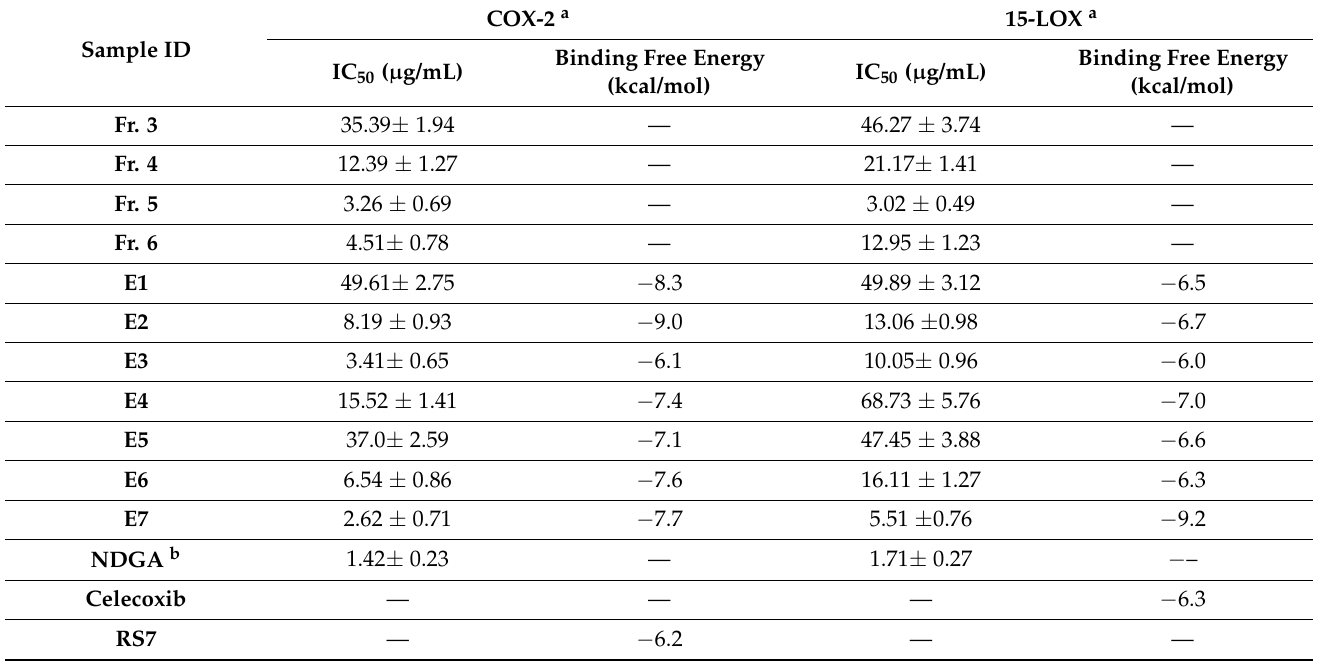
Table 5. IC 50 and binding free energies of cyclooxygenase-2 (COX-2) and 15-lipoxygenase (15-LOX)- inhibitory activities of the selected sub-fractions and isolated compounds ( E1 – E7 ) from E. erinaceus